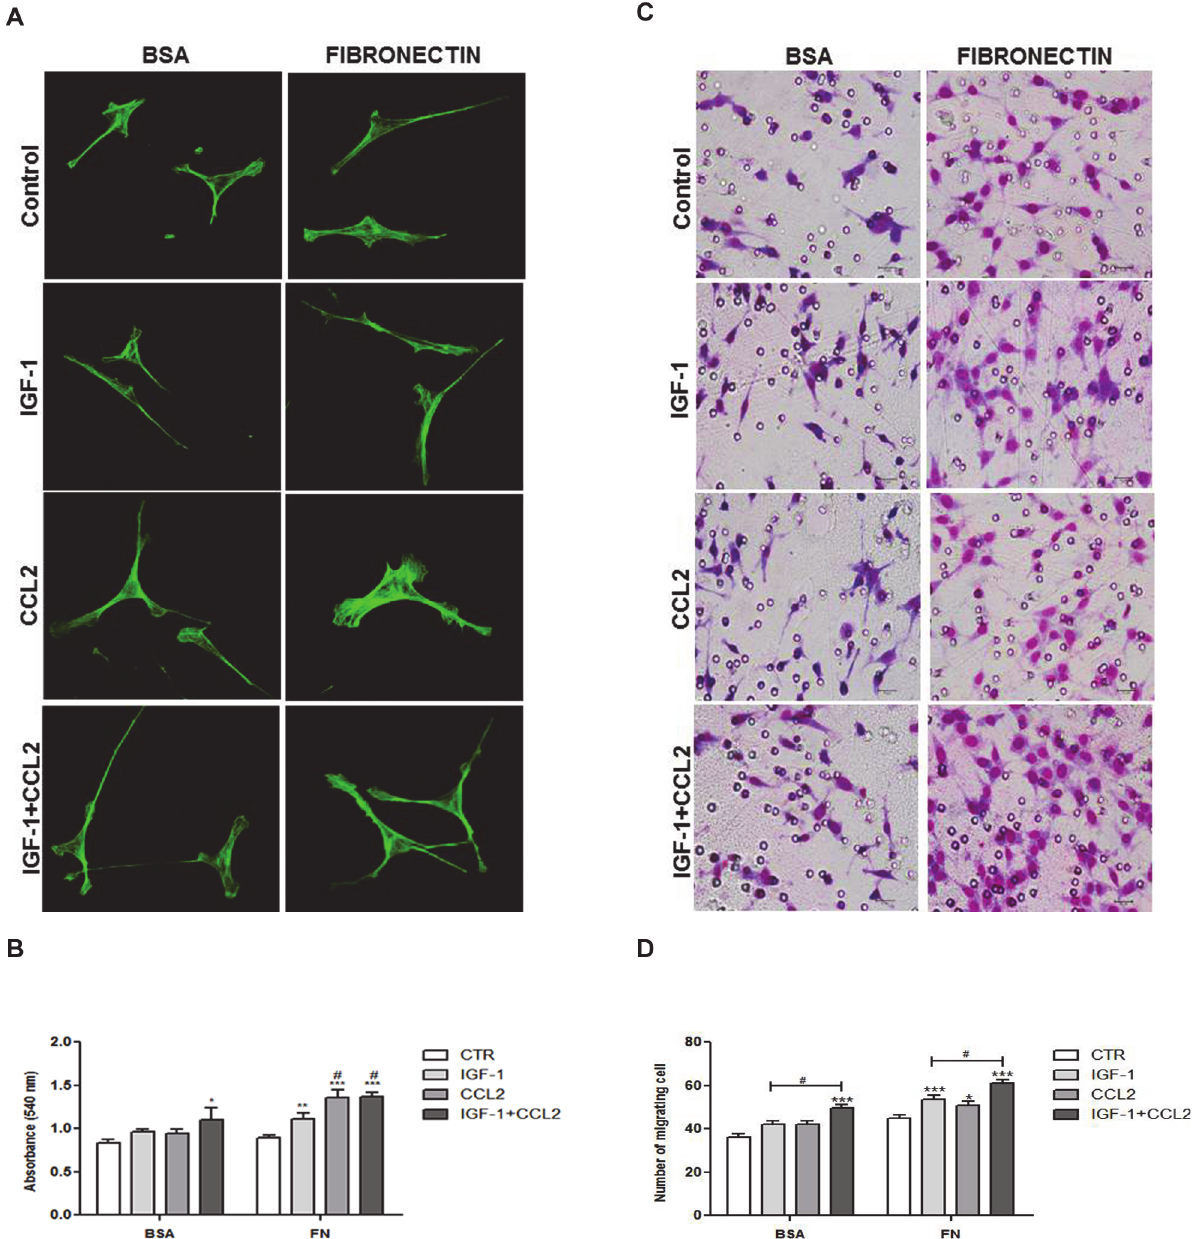
Fig 3. IGF-1 and/or CCL2 increased adhesion and migration of tEnd.1 cells. (A) tEnd.1 cells treated with IGF-1 (100 ng/mL), CCL2 (10 ng/mL), or a combination of both for 24 h on BSA or FN coating were stained with Alexa 488-phalloidin and analyzed by confocal microscopy with a 63× objective. ( B ) tEnd.1 cells were allowed to adhere on BSA- or FN-coated surfaces for 1 h after stimulation with IGF-1, CCL2, or IGF-1/CCL2 for 24 h. ( C ) tEnd.1 cells were allowed to migrate through transwell chambers coated with BSA or FN after chemotactic stimulation with IGF-1, CCL2, or IGF-1/CCL2 for 6 h. Photomicrographs demonstrate cells invading through the transwell membrane. Giemsa staining. Scale bar = 10 μ m. ( D ) Bars represent the number of migrating cells in a transwell system. Data are represented as mean ± SEM (n = 5/group). Results were analyzed by two-way ANOVA followed by Bonferroni ’ s post-test. Significant values compared to control group: p < 0.05 ( * ), p < 0.01 ( ** ), or p < 0.0001 ( *** ); significant values compared to control group and the IGF-1 treatment: p < 0.05 (#); and significant values compared to control group and single treatments: p < 0.01 (+).